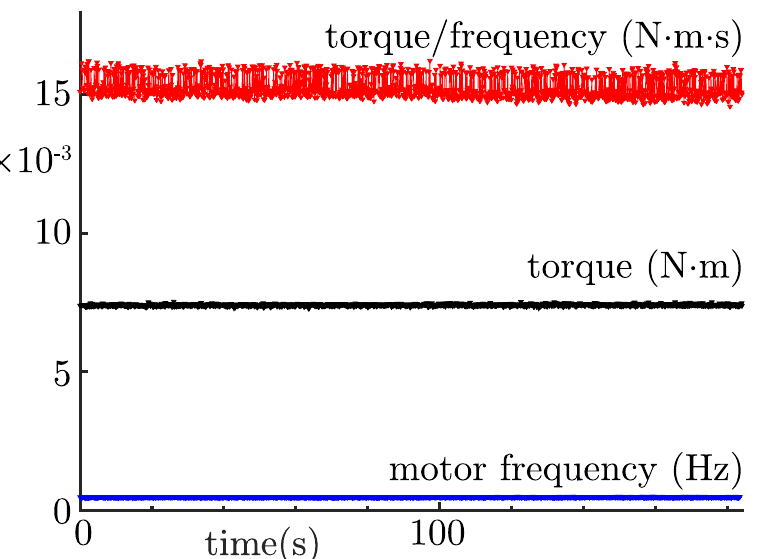
Figure 6. Example of data signals from the experimental torque measurements. The frequency and torque data were read by the DAQ, and the torque per unit frequency was calculated in real time and was smoothed to remove outliers as described in the